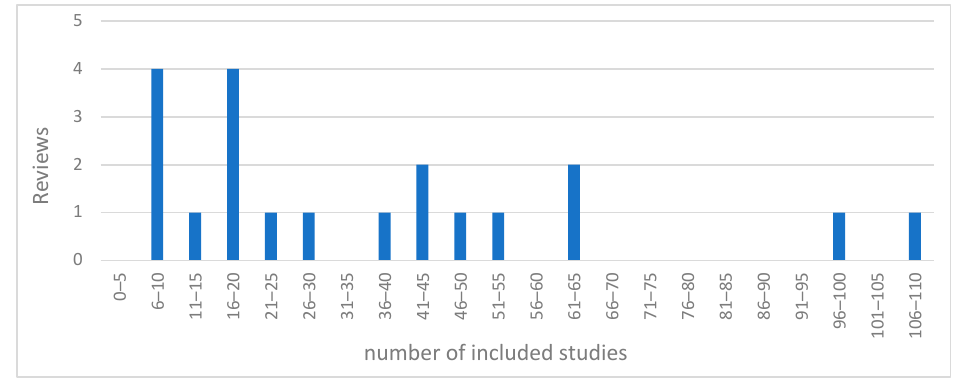
Figure 1. Number of studies analyzed in each review.